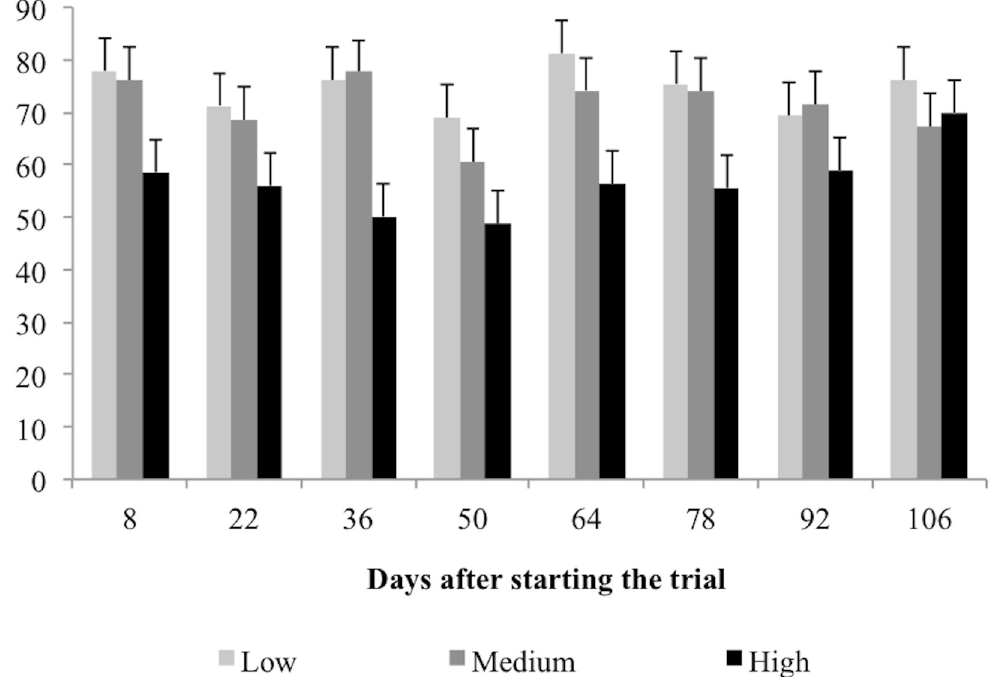
Fig 2. Mean percentage of H . placei -specific serum IgG levels against L3 worm crude antigen for groups Low, Medium, and High showing Fecal Egg Counts (FEC). Data are the mean of duplicates ( ± ) SE given as a percentage of optical density of the positive reference serum. There was a difference between groups (P = 0.03) and days (P = 0.002) for IgG against L3 but no significant (P < 0.05) interaction between groups and days.